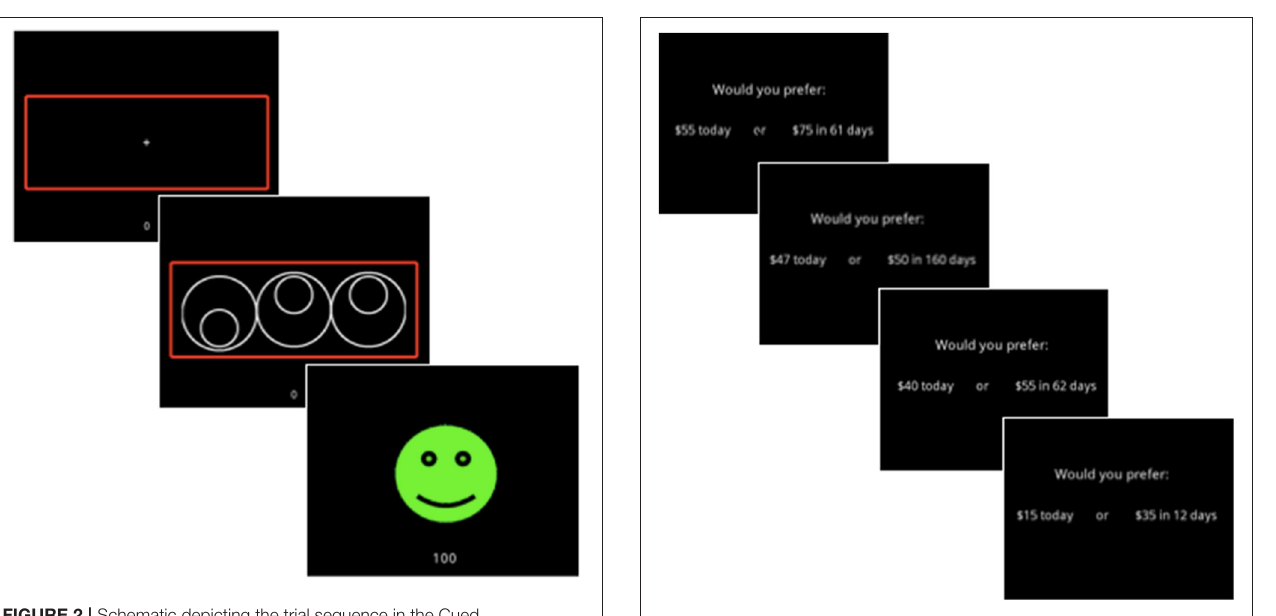
FIGURE 3 | Examples of items utilized in the Kirby Delay Discounting questionnaire [Kirby DD; (